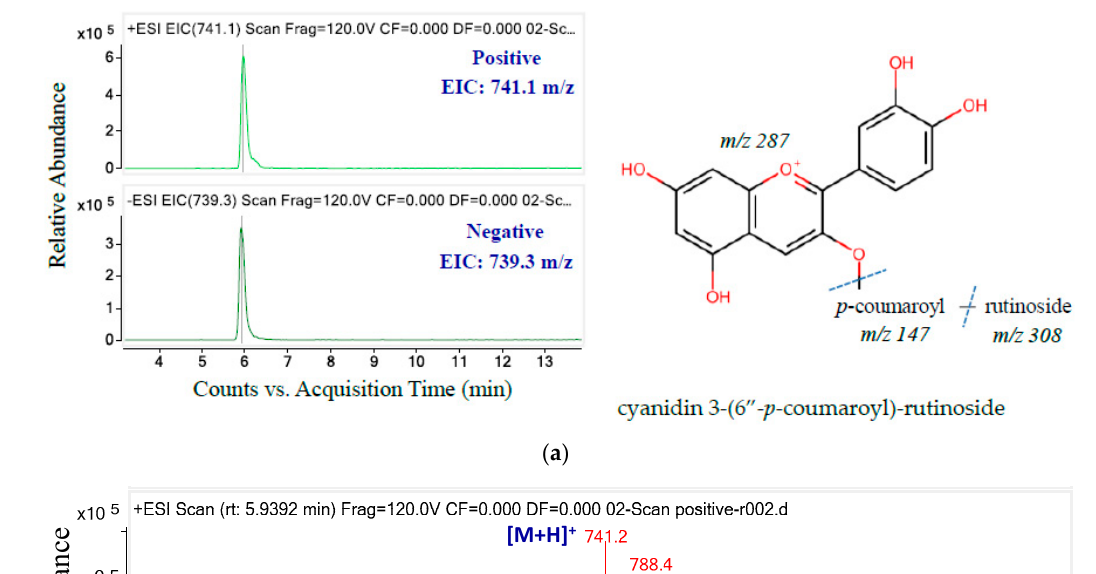
Figure 4. Compound 2 exhibited a molecular ion [M + H] + with m / z 741.1 and produced a major fragment with m / z 286.9 that may correspond to cyanidin ( m / z 287). In addition, p-coumaroyl fragment ( m / z 147), this compound could be tentatively identified as cyanidin 3-(6 (cid:48)(cid:48) - p -coumaroyl)-rutinoside [37].